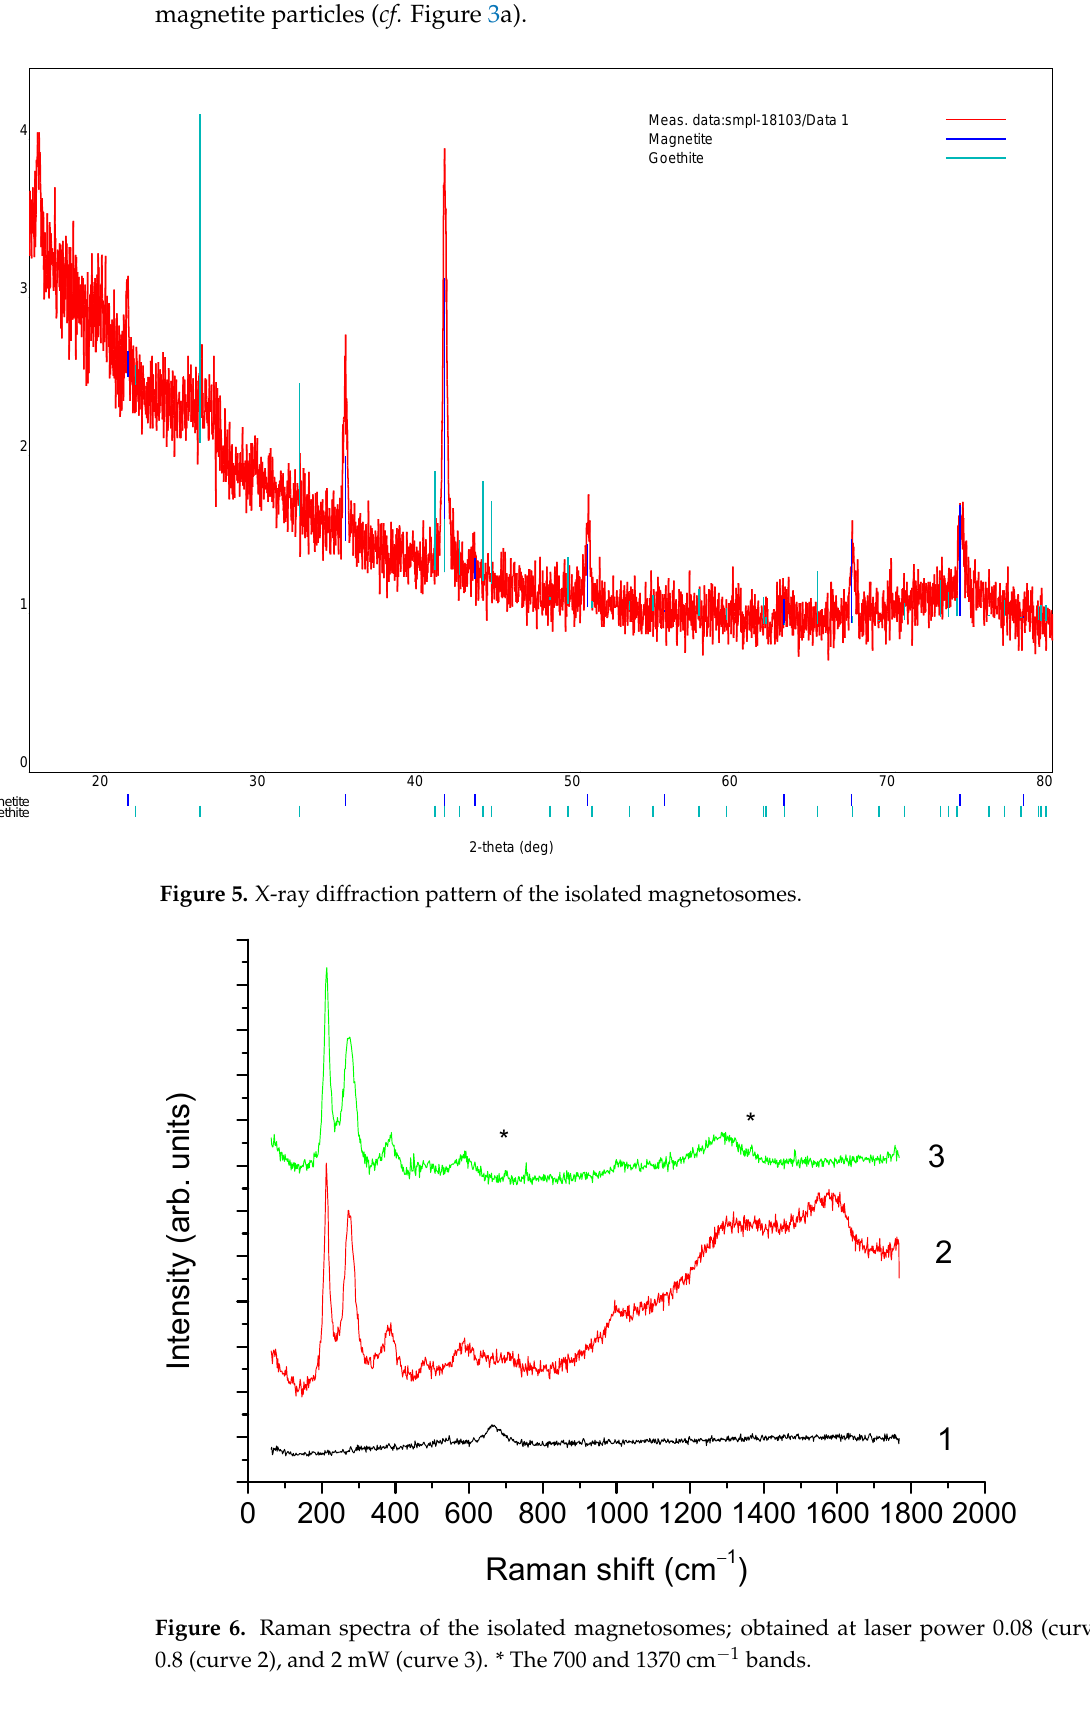
Figure 6. Raman spectra of the isolated magnetosomes; obtained at laser power 0.08 (curve 1), 0.8 (curve 2), and 2 mW (curve 3). * The 700 and 1370 cm −1 bands.